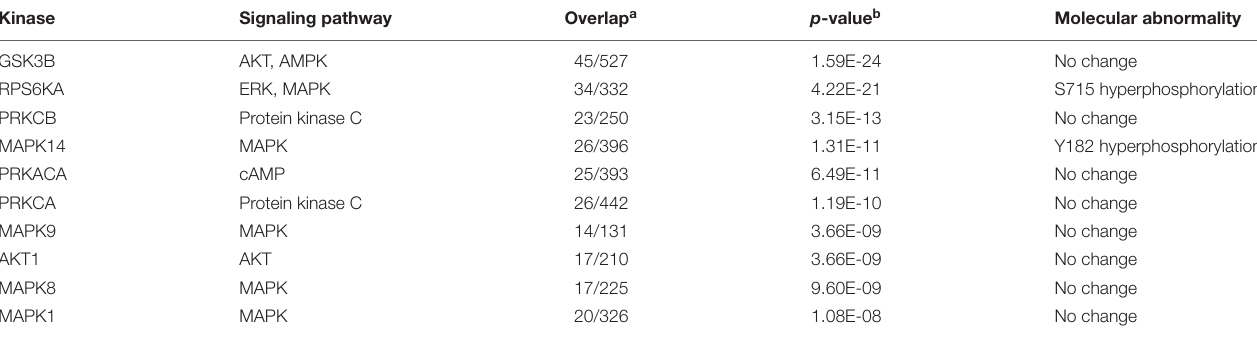
TABLE 2 | Top candidate kinases with overpresented hyperphoshprylated substrates in DMSXL astrocytes. Kinase Signaling pathway Overlap a p -value b Molecular abnormality